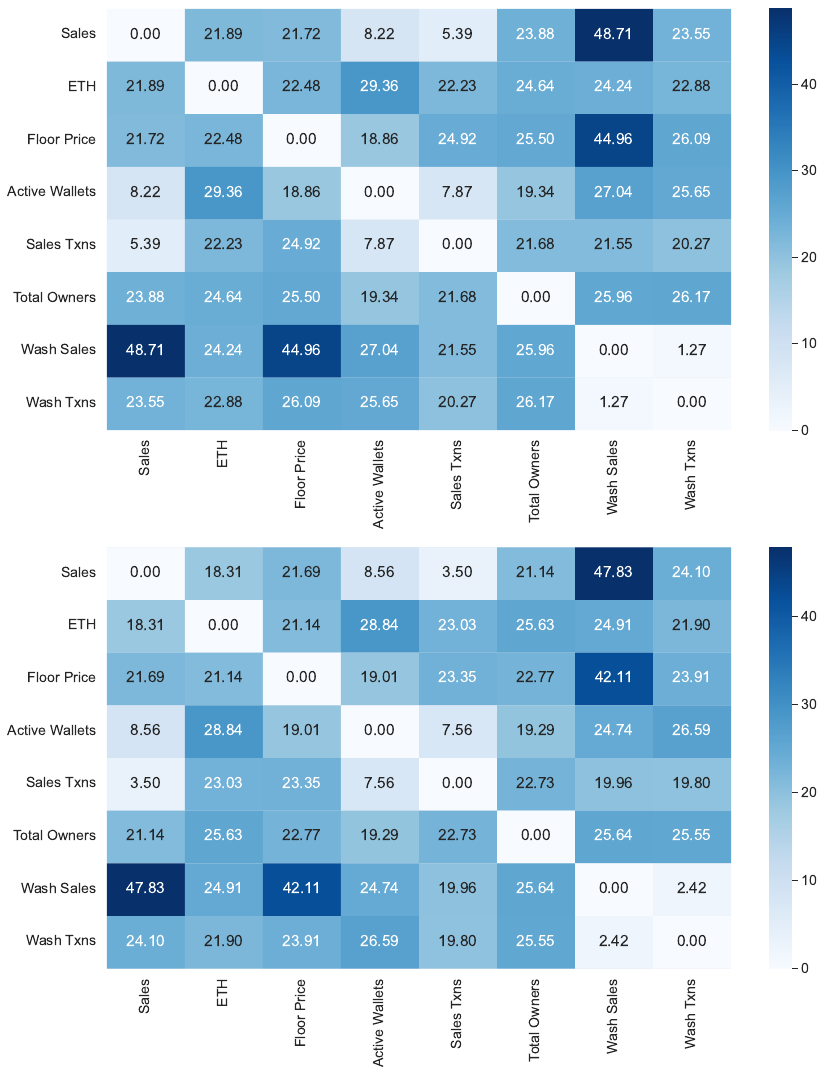
Figure 9. DTW distance values between all the pairs of features for Azuki, BAYC, and